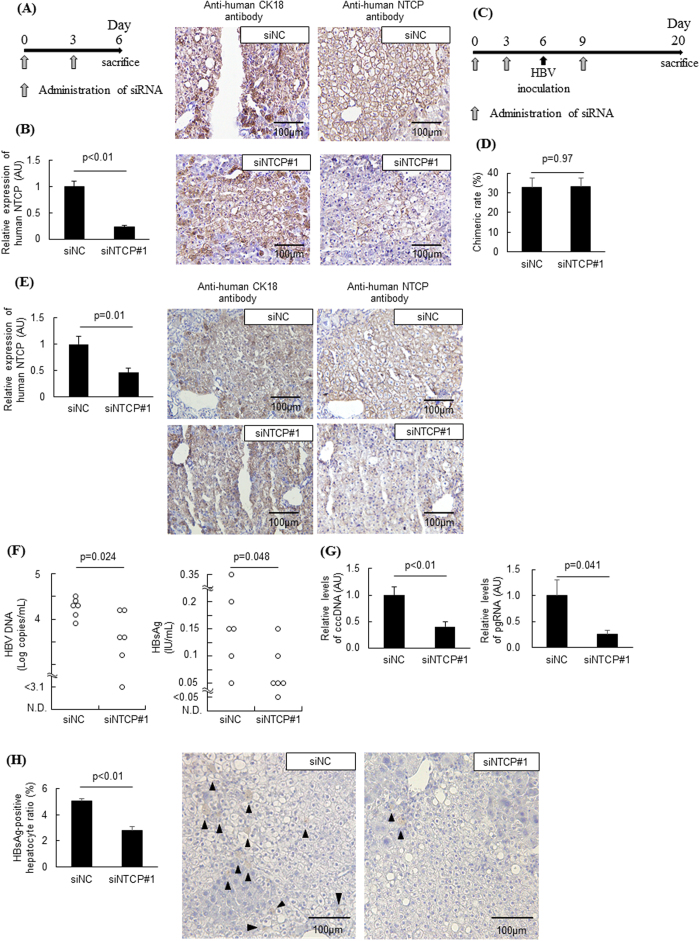
NTCP inhibition suppressed the spread of HBV infection in vivo.(A,B) Humanized liver chimeric mice were transfected twice with siRNA against human-specific NTCP. Liver specimens were immunostained with anti-human-specific CK18 and NTCP antibodies. CK18 is expressed in hepatocytes, and positive staining for human CK18 indicated the presence of human hepatocytes. Schematic of experimental procedure (A). Human NTCP expression levels (n = 5, each spot is from 1 chimeric mouse) and representative images of NTCP and CK-18 immunohistochemical staining of serial liver sections (B). (C–H) Humanized liver chimeric mice were transfected with siRNA against human-specific NTCP before and after HBV inoculation and sacrificed 2 weeks after inoculation (n = 6). Schematic of experimental procedure (C). The chimeric rates in each group at the time of HBV inoculation (D). NTCP expression levels (E). Serum HBV DNA and HBsAg levels were compared using the Mann-Whitney U test (F). cccDNA and pgRNA levels in hepatocytes (G). The ratio of HBsAg-positive human hepatocytes and representative images of HBsAg immunohistochemical staining. Arrowheads indicate HBsAg-positive hepatocytes (H). AU; arbitrary unit.